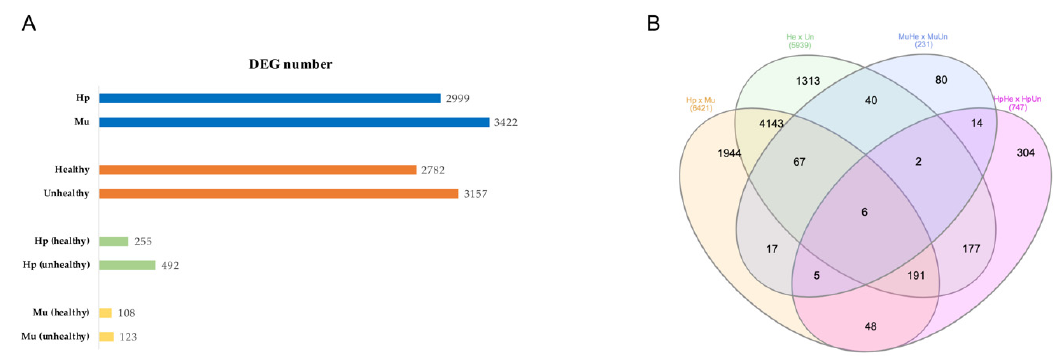
Figure 1. ( A ) Number of Di ff erentially Expressed Genes (DEGs) detected for the four comparisons performed in the Litopenaeus vannamei transcriptome. ( B ) DEGs union. The total of 8351 unique DEGs from all the four analysis are represented by the sum of the values inside the Venn diagram. Hp x Mu: hepatopancreas (Hp) versus muscle (Mu); He x Un: healthy (He) versus unhealthy (Un), considering the tissue e ff ect; MuHe x MuUn: muscle of healthy (MuHe) versus muscle of unhealthy (MuUn); and HpHe x HpUn: hepatopancreas of healthy (HpHe) versus hepatopancreas of unhealthy (HpUn) shrimps. WSSV: White Spot Syndrome Virus.